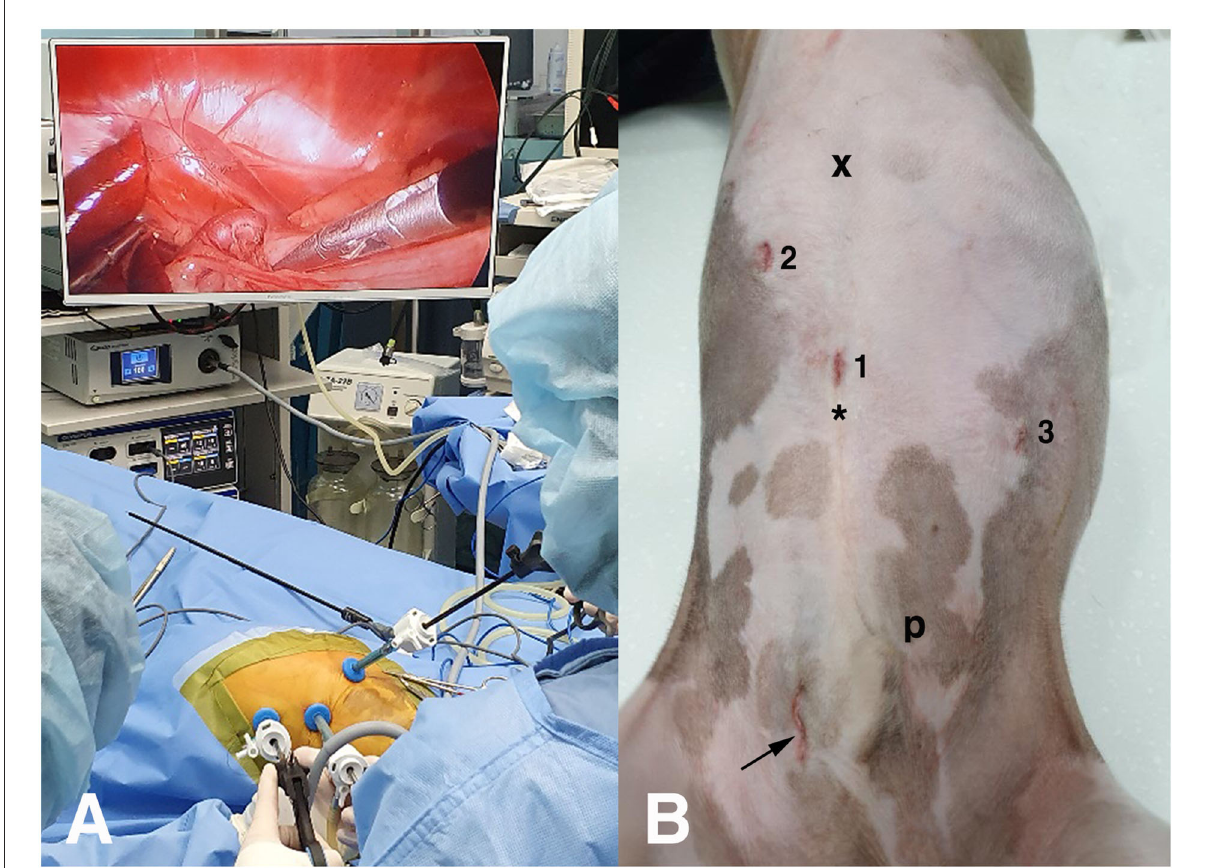
FIGURE2 Laparoscopic tower set-up (A) and portal sites (B) for laparoscopic attenuation of canine splenophrenic shunt using thin-film banding. x, xiphoid process; 1, primary port; 2, second port; 3, third port; asterisk, umbilicus; arrow, mini-laparotomy site for cystolithotomy; p,